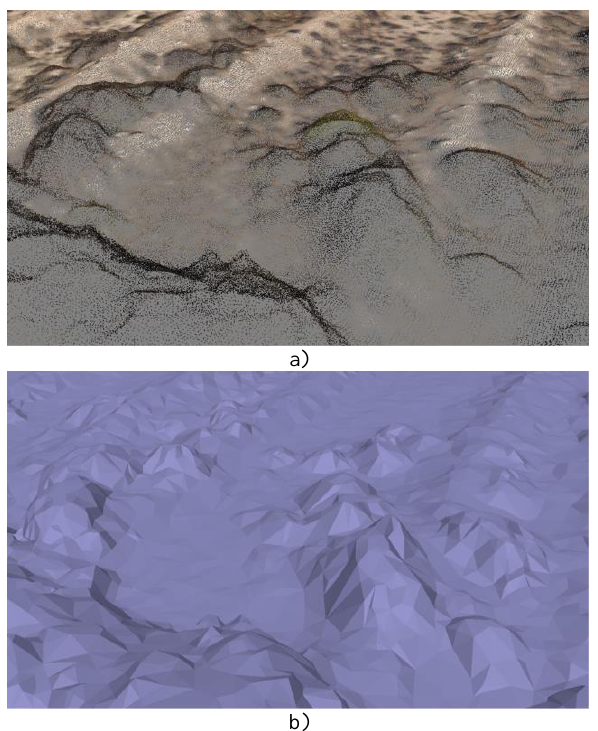
Figure 7. Perspective of a detail of the area study a) dense point